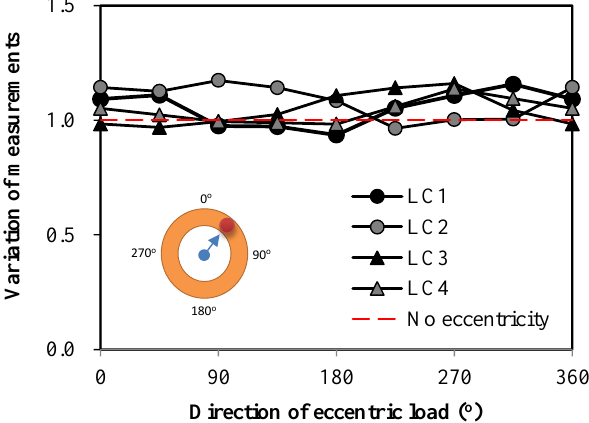
Figure 6. Variations of measurements in relation to the direction of eccentric loads.